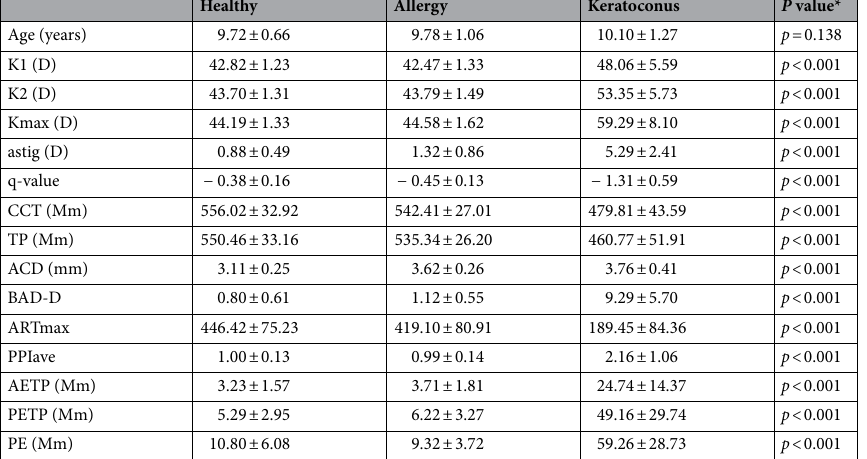
Table 1. Demographics and corneal parameters from the OCULUS Pentacam for healthy, ocular allergy, and keratoconus groups. K1 flat keratometry, K2 steep keratometry K max maximum keratometry, Astig astigmatism in Sim K, CCT central corneal thickness, TP thinnest pachymetry, ACD anterior chamber depth, BAD-D Belin/Ambrosio enhanced ectasia display, ARTmax Ambrosio’s relational thickness maximum, PPIave average pachymetric progression index, AETP anterior elevation at the thinnest point, PETP posterior elevation at the thinnest point, PE maximum posterior elevation. *Kruskal–Wallis test.